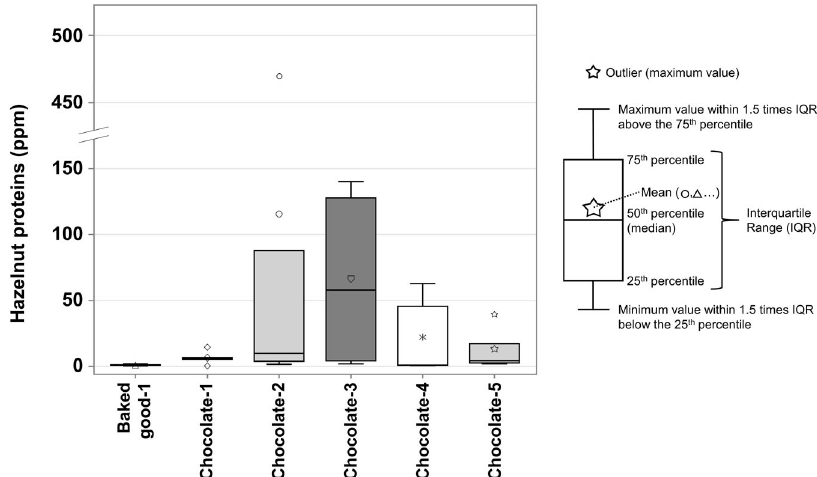
Fig. 5 Variation in hazelnut protein concentration between fi ve lots of six different products with 5/5 lots positive for hazelnut. Each box corresponds to a different product (chocolate or baked good) and has a different color-symbol combination. Each box (or product) displays the results of the fi ve positive lots for hazelnuts. The product “ Chocolate-2 ” presents one outlier. There were no other products with 5/5 lots positive for